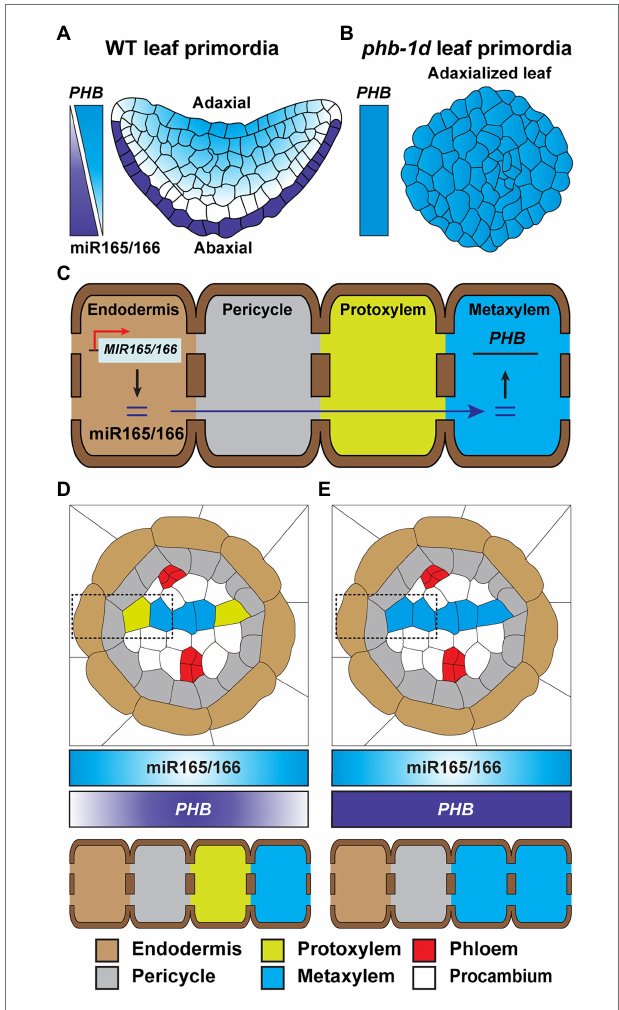
FIGURE 4 | Mobile miR165/166 establishes developmental patterns in leaf and root. (A) The biosynthesis of miR165/166 is specifically detected in the abaxial epidermis of Arabidopsis WT leaf primordia. The concentration gradient of miR165/166 is generated from the abaxial to adaxial side of the leaf primordia, via its intercellular movement, leading to a horizontal level gradient of PHB transcript, which is the target gene of miR165/166, from the adaxial to abaxial region, in order to restrict PHB expression on the adaxial side and, thereby, confer abaxial–adaxial polarity (Juarez et al., 2004; Yao et al., 2009). (B) The phd-1d mutant carries a compromised miR165/166-binding site in the PHB gene and, thereby, impaired miR-mediated PHB silencing. The gain-of- function mutation of phd-1d results in a high-level expression of PHB in developing leaves, leading to the generation of an adaxialized leaf phenotype (Mcconnell and Barton, 1998; Carlsbecker et al., 2010). (C) The mature miR165/166 is strictly produced in the root endodermis. The miR165/166 then moves from the endodermis into the stele in the root, which generates an miR165/166 gradient that decreases toward the root stele. This gradient leads to an inverse gradient in abundance of the miR-targeted PHB transcripts. The resultant elevated level of PHB expression results in protoxylem and metaxylem formation in the stele ( D ; Carlsbecker et al., 2010; Miyashima et al., 2011; Vatén et al., 2011; Brosnan et al., 2019; Brioudes et al., 2021; Fan et al., 2021). (E) Similar to phd-1d , shown in (B) , a gain-of-function phd-7d mutant develops metaxylem at the protoxylem position due to impaired miR165/166- mediated PHB gene silencing (Carlsbecker et al., 2010; Miyashima et al., 2011; Fan et al., 2021). In (D,E) , endodermis, pericycle, protoxylem, and metaxylem are shown in dotted